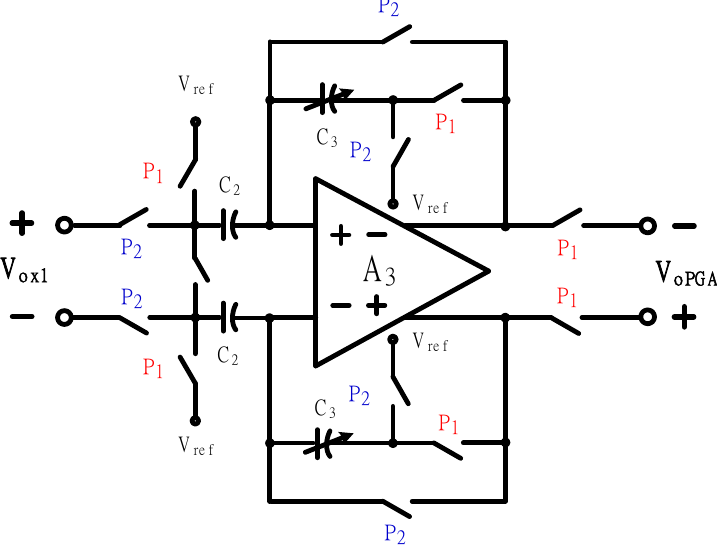
Figure 4. CDS configuration of the programmable gain amplifier (PGA) in the second stage.